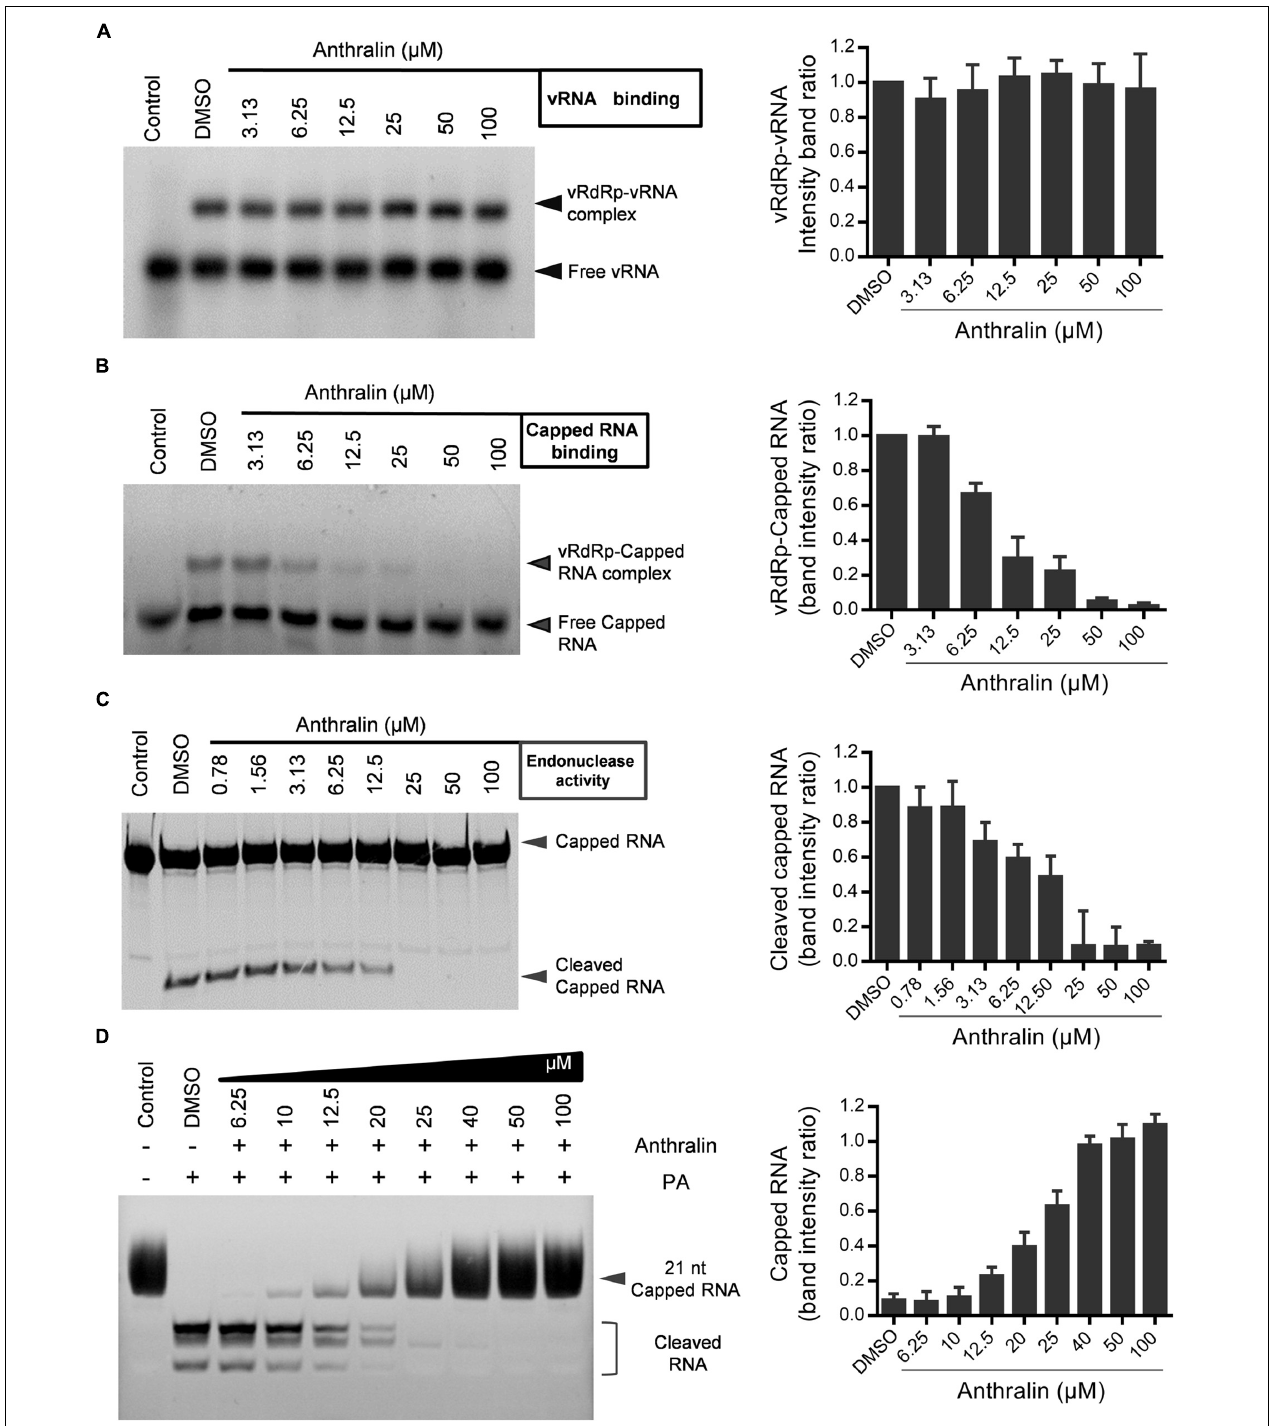
FIGURE 5 | Anthralin inhibits the cap-snatching activity of viral RdRp. (A) Binding of vRNA to vRdRp. The polymerase complexes were incubated at 37 ◦ C for 30 min in the binding buffer with 5 (cid:48) FAM-labeled vRNA. The protein-RNA complexes were resolved from free RNA by electrophoresis on 4% non-denaturing gels. (B) Cap-binding analysis in a gel shift assay. Following 30 min reaction for the binding of an unlabeled oligoribonucleotide containing the vRNA, the 20-nucleotide-long capped RNAs marked by 5 (cid:48) -FAM were added, and then incubated in the presence or absence of anthralin for 30 min at 37 ◦ C. The complexes were separated from free RNA by electrophoresis on 4% non-denaturing gels. (C,D) Endoribonuclease assays. 5 (cid:48) FAM-labeled Capped RNA, vRNA, diluted series anthralin and vRdRp (C) or PA subunit alone (D) were mixed and incubated with 0.1 µ g of tRNA as an additional inhibitor of non-specific nucleases at 37 ◦ C water bath for 60 min and samples were analyzed on a 20% acrylamide, 7 M urea denaturing gel.